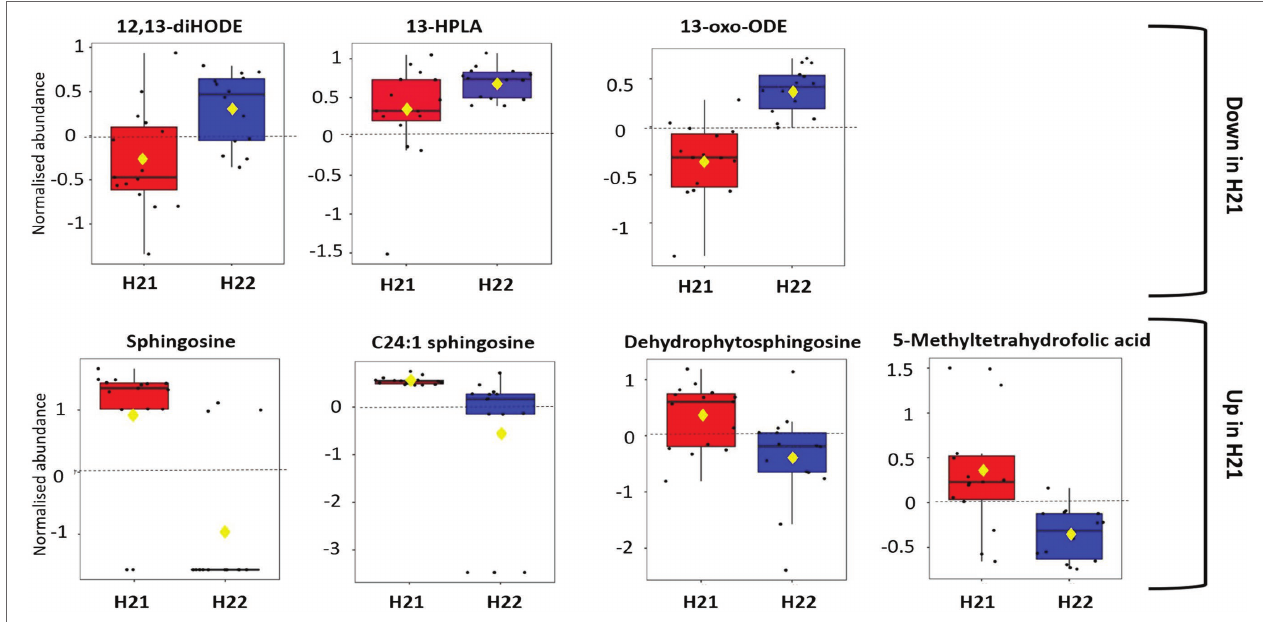
FIGURE 3 | Boxplot analysis of selected metabolites. Black dots represent the normalized abundance of selected features in all samples. The notch indicates 95% CI around the median of each group, defined as ±1.58*IQR/sqrt(n). The mean concentration is indicated with a yellow